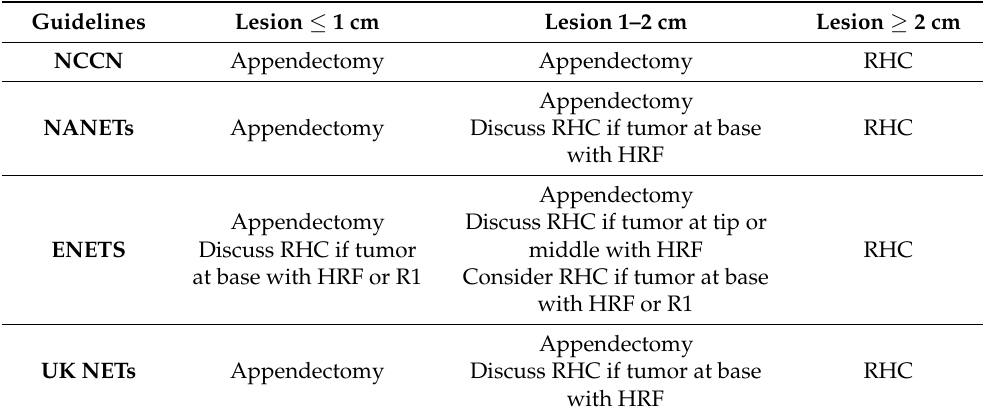
Table 2. Management Strategies for localized Appendiceal Neuroendocrine Tumor According to Different Guidelines